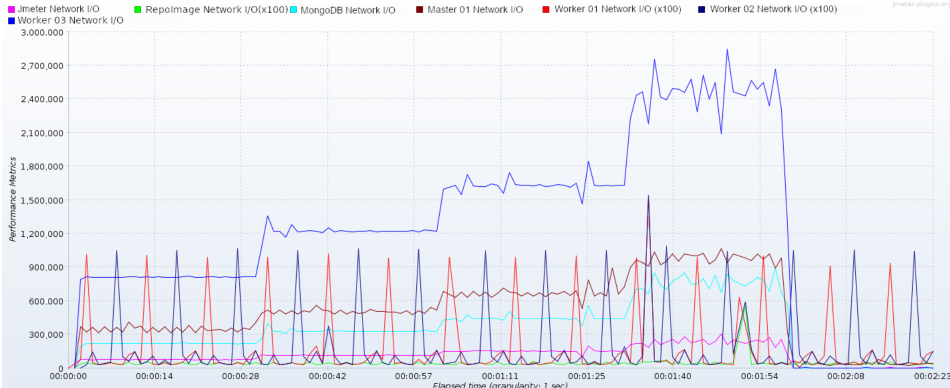
Figure 13. Network costs reported by the Ayni application deployed on two